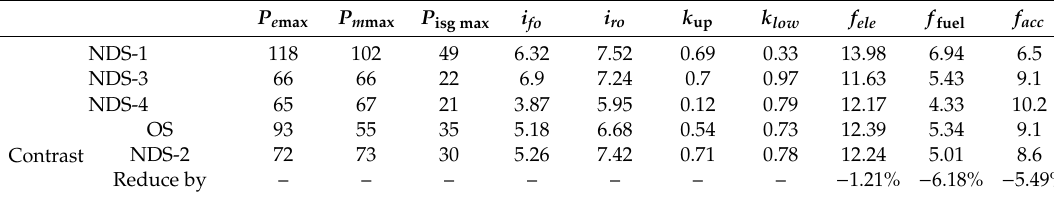
Table 4. The results for NDS-1, NDS-2, NDS-3, NDS-4 and the original scheme (OS).